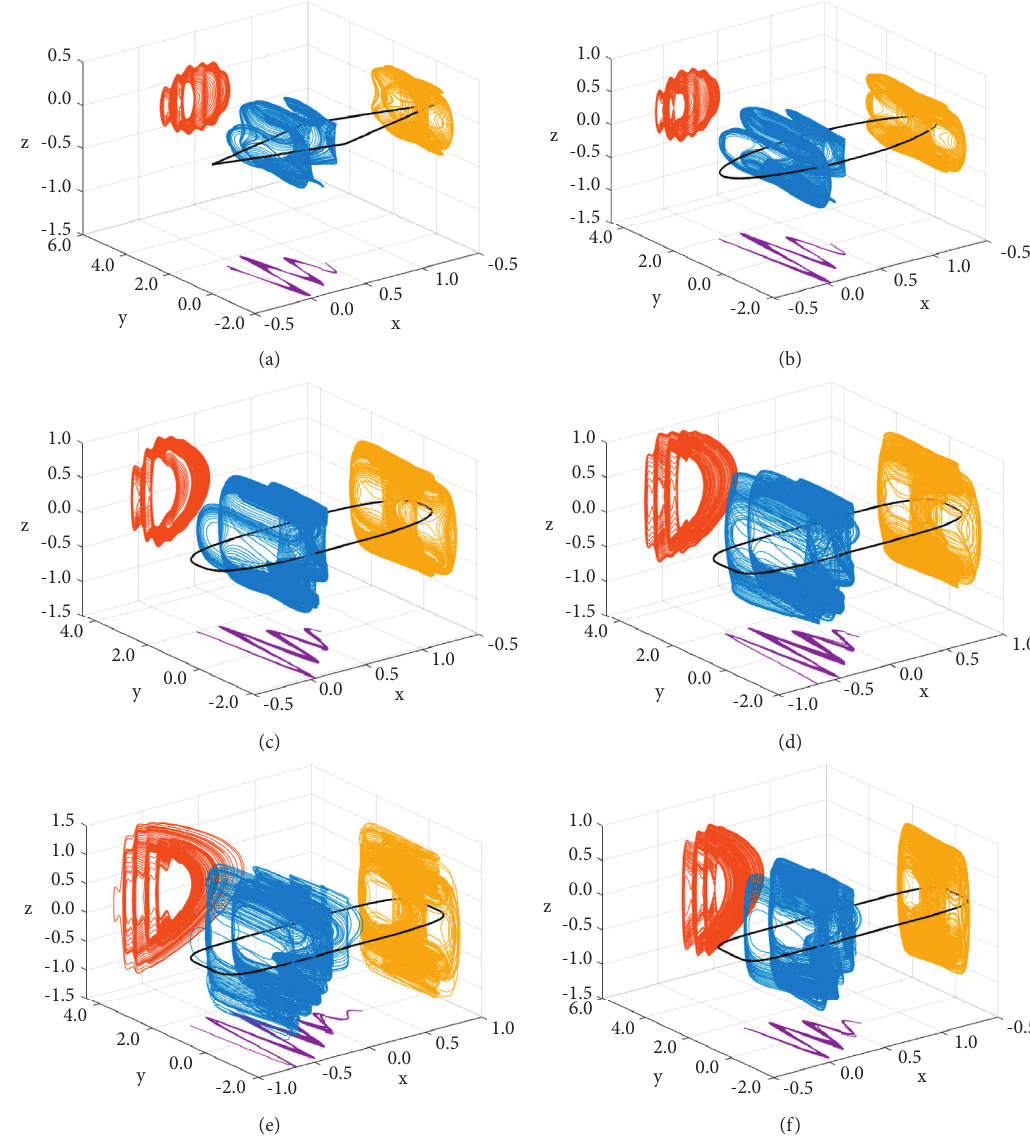
Figure 3: Phase diagram of the difference in integer k . (a) k � 1. (b) k � 2. (c) k � 3. (d) k � 4. (e) k � 5. (f) k � 6.